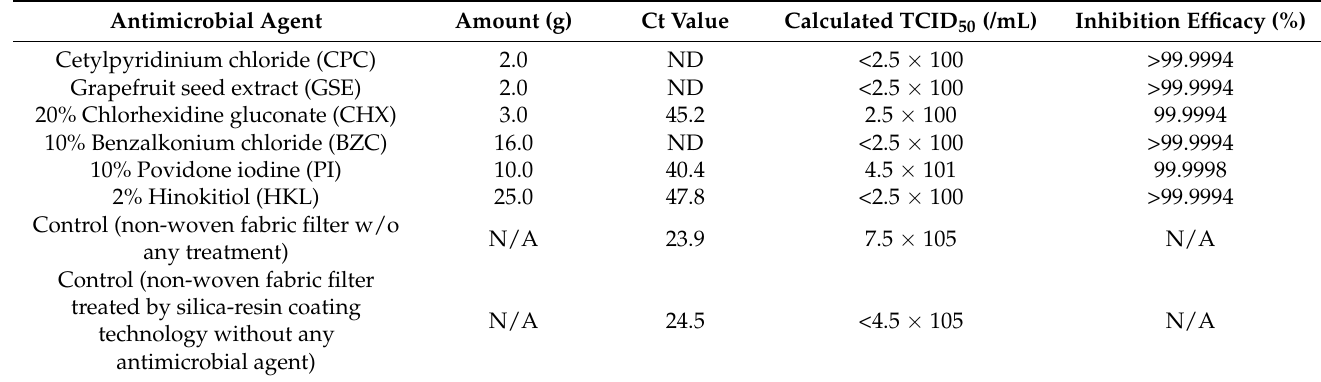
Table 2. Antiviral efficacy of non-woven fabric filters treated with silica-resin coating technology and antimicrobial